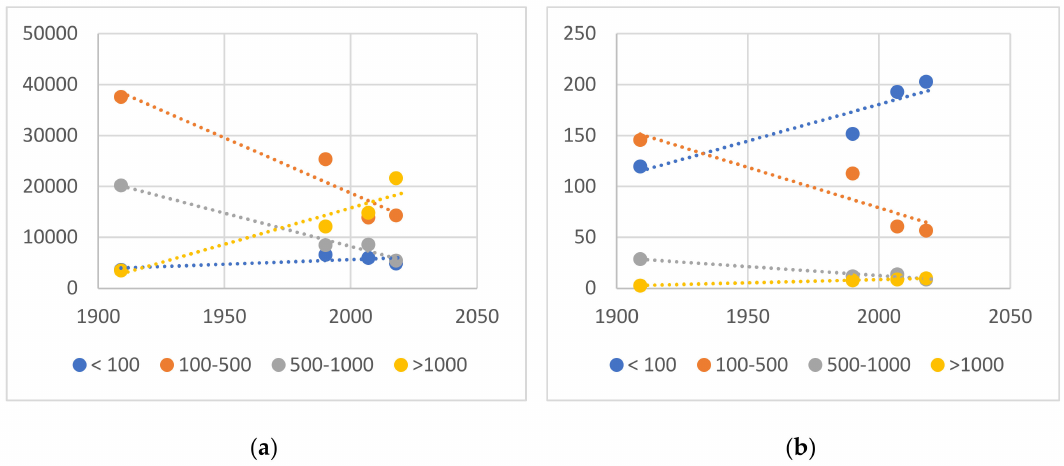
Figure 6. Changes and trends in the rural settlement system within the current boundaries of the Mogilev district: ( a ) population; ( b ) rural settlement